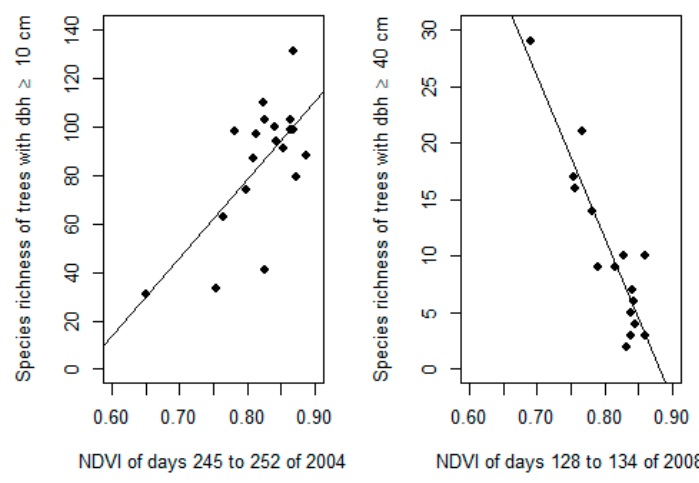
Figure 3. Best correlations found between tree species richness (with a diameter at breast height (dbh) above 10 cm on the left and 40 cm on the right) and individual NDVI scenes selected from a 15-year MODIS NDVI time series using our screening approach.